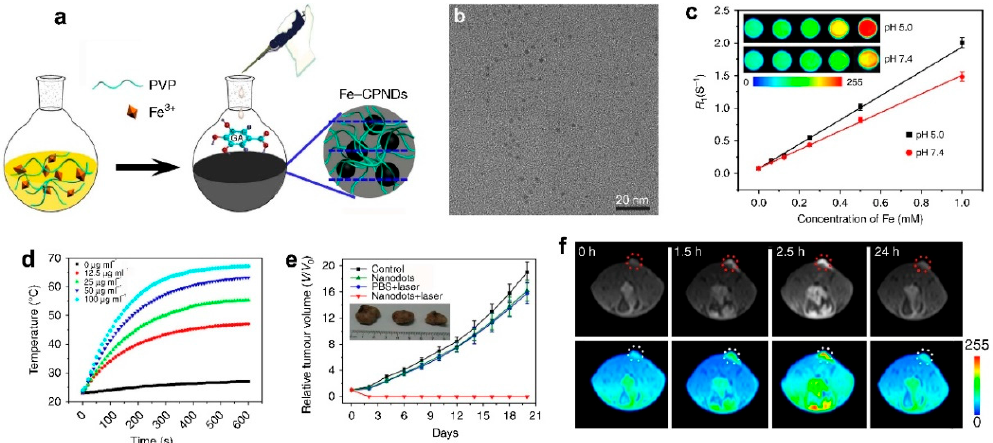
Figure 11. ( a ) Schematic representation of the synthesis of Fe-CPNDs. ( b ) TEM micrograph of Fe-CPNDs. ( c ) The effect of solution pH on the R 1 relaxivity of Fe-CPNDs. ( d ) Temperature elevation of Fe-CPNDs solutions with various concentrations under 1.3 W cm − 2 808 nm NIR laser irradiation for 10 min. ( e ) Tumor growth curves of different groups of mice after intravenous treatments. The inset shows the digital photographs of tumors collected from different groups of mice at day 20th post-administration. ( f ) In vivo MR images of the SW620 tumor-bearing nude mouse after intravenous injection of at a dose of 0.25 mg Fe kg − 1 (The tumor was marked by circle, which was about 5 mm 3 in volume.) after the intravenous injection of Fe-CPNDs at different time intervals (0 h indicates pre-injection) (adapted from Liu et al. 2015 [107], Copyright 2015 Macmillan Publishers Ltd. and reproduced with permission).